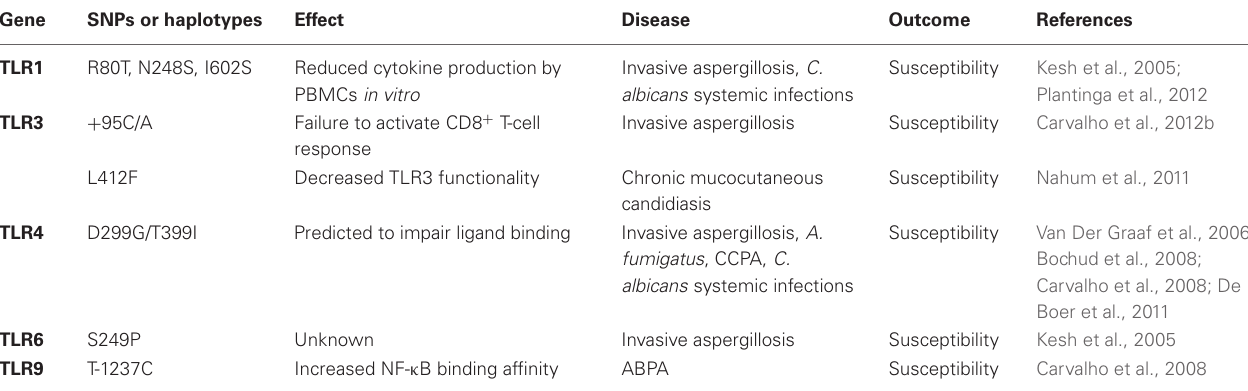
Table 1 | TLR polymorphisms associated with increased susceptibility to fungal